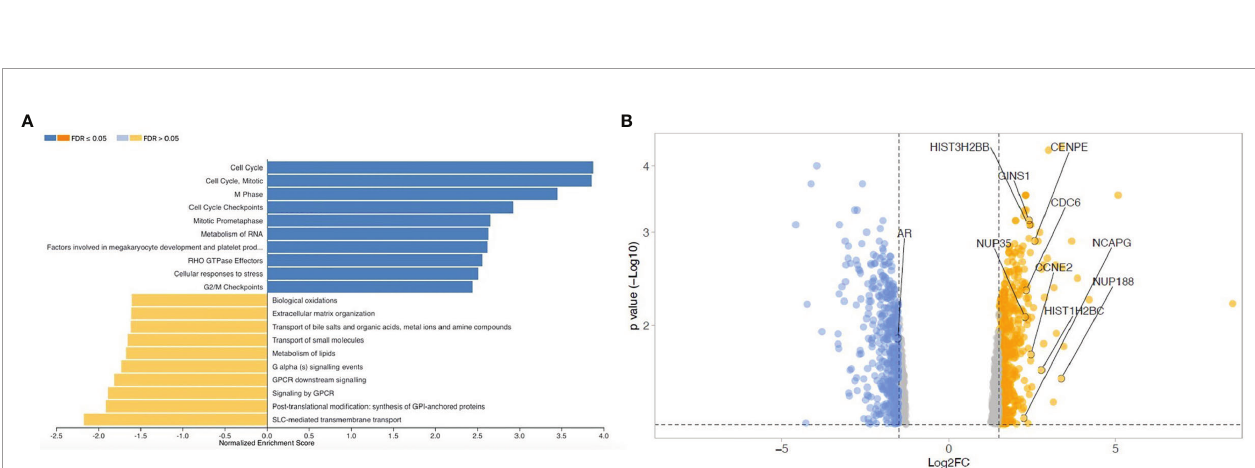
FIGURE 2 | Transcriptomic analysis on C4-2B FR treated with OCM and C4-2B CM. (A) Gene set enrichment analysis and (B) Volcano plot of down- (blue) and upregulated genes (red) in C4-2B FR treated with OCM (fold change ˃ 1.5). Top 10 genes ranked by enrichment score for gene set “ cell cycle R-HAS-1640170 REACTOME ” and androgen receptor (AR) are labeled.